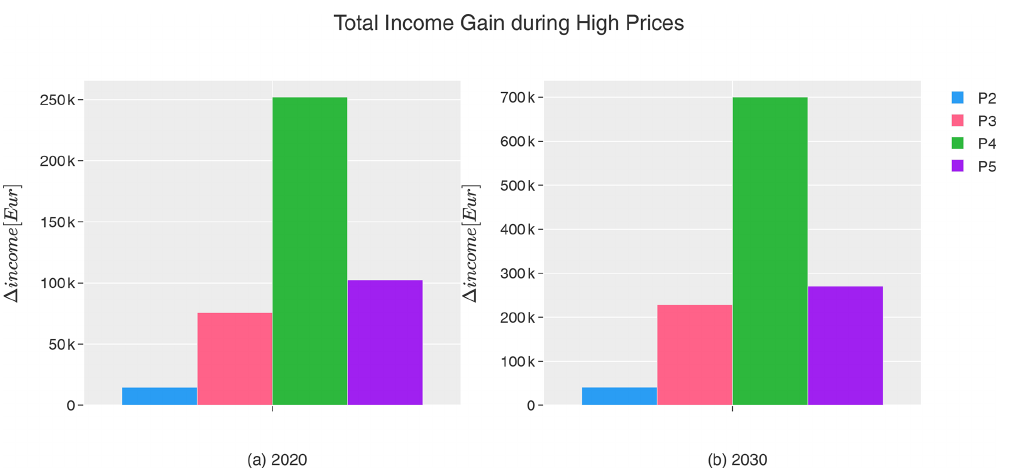
Figure 9. Total income gain ( (cid:49) income) in EUR when using wind farm flow control (WFFC) in simulations with the wind inflow and price information as shown in Fig. 1 for 2020 (a) and 2030 (b) , compared to the production under normal operation without WFFC. Each bar indicates the results for one of the participants P2–P5.